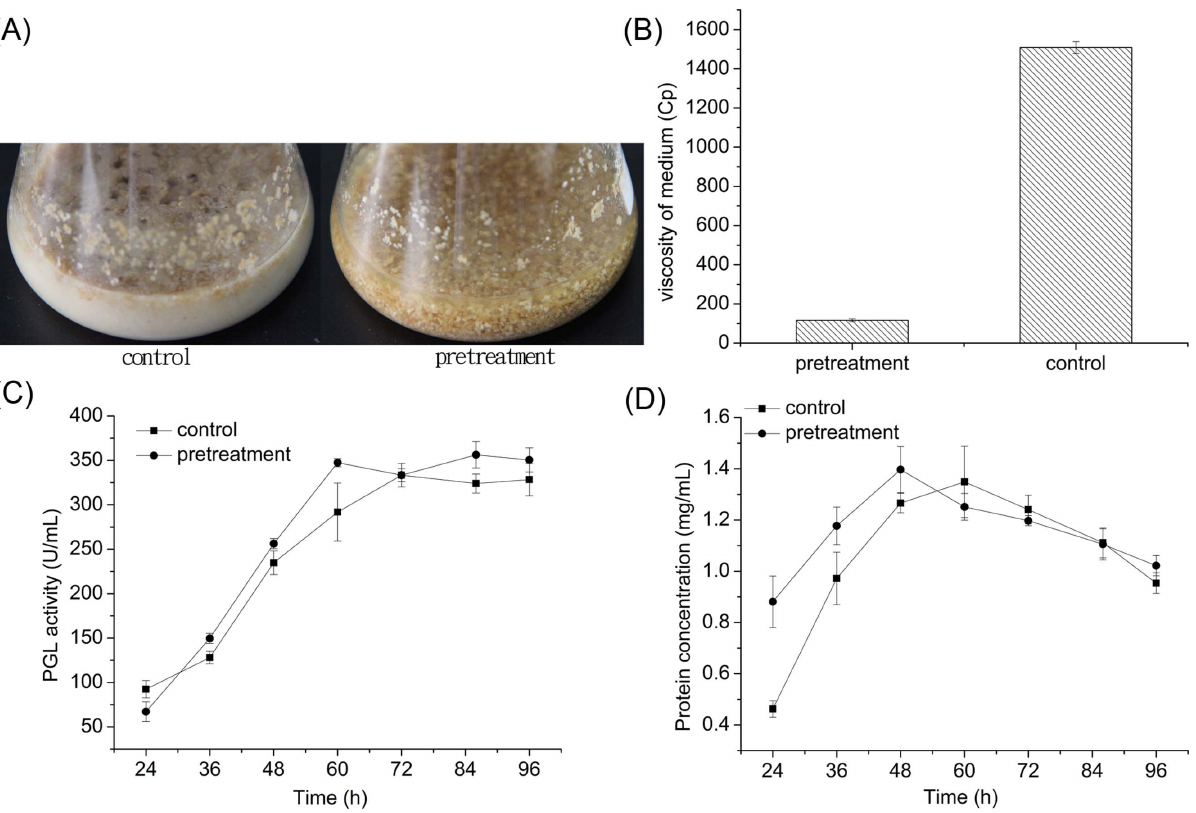
Figure 2. Effect of pretreating the carbon source in the feeding medium with mesotherm amylase on the state (A), viscosity of feeding medium (B), PGL activity (C), and protein concentration (D).